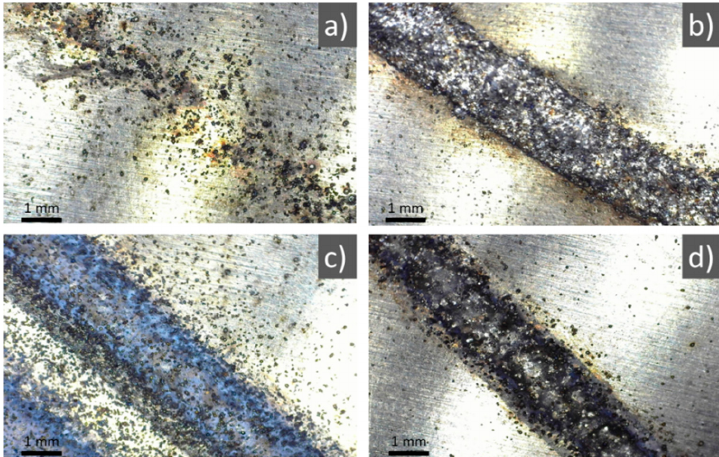
Figure 3. Ti6Al4V deposited along a linear trajectory during two passes of the laser beam and powder nozzle: ( a ) 800 W peak power and 0.3 m/min scanning speed; ( b ) 1000 W peak power and 0.3 m/min scanning speed; ( c ) 1200 W peak power and 0.3 m/min scanning speed; ( d ) 1200 W peak power and 1 m/min scanning speed. Magnification bar: 1 mm.